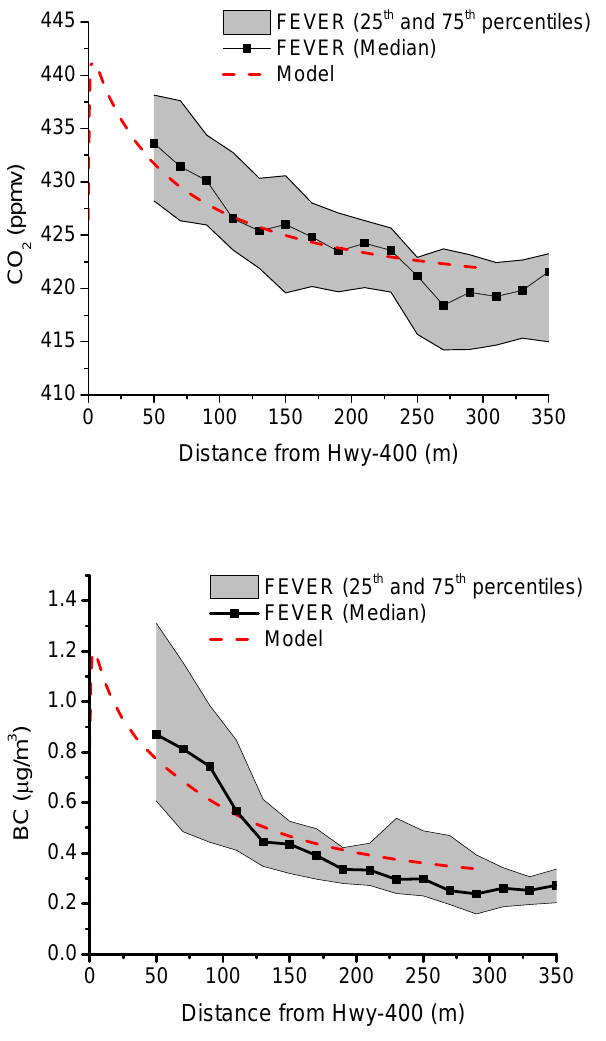
Figure 5. Particle number–size distributions at site B (34m from Fig. 5. Particle number-size distributions at site B (34 m from the hwy centre) and site C 5 the highway center) and site C (300m from the highway (300 m from the hwy centre). 6